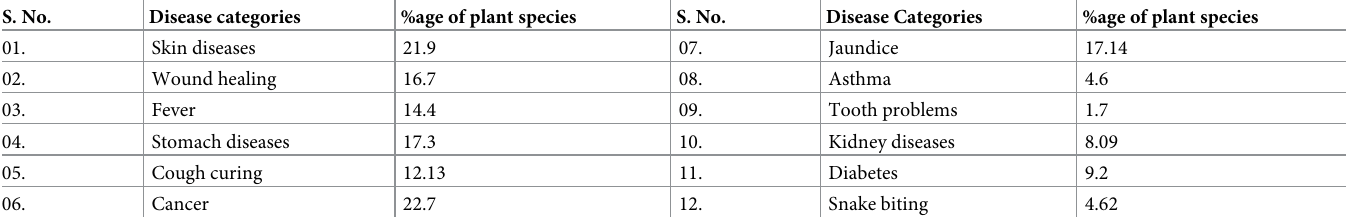
Table 3. Percentage of plant species used for treatment of different diseases from Shiwalik mountain range of District Bhimber of Azad Jammu and Kashmir, Pakistan. S.